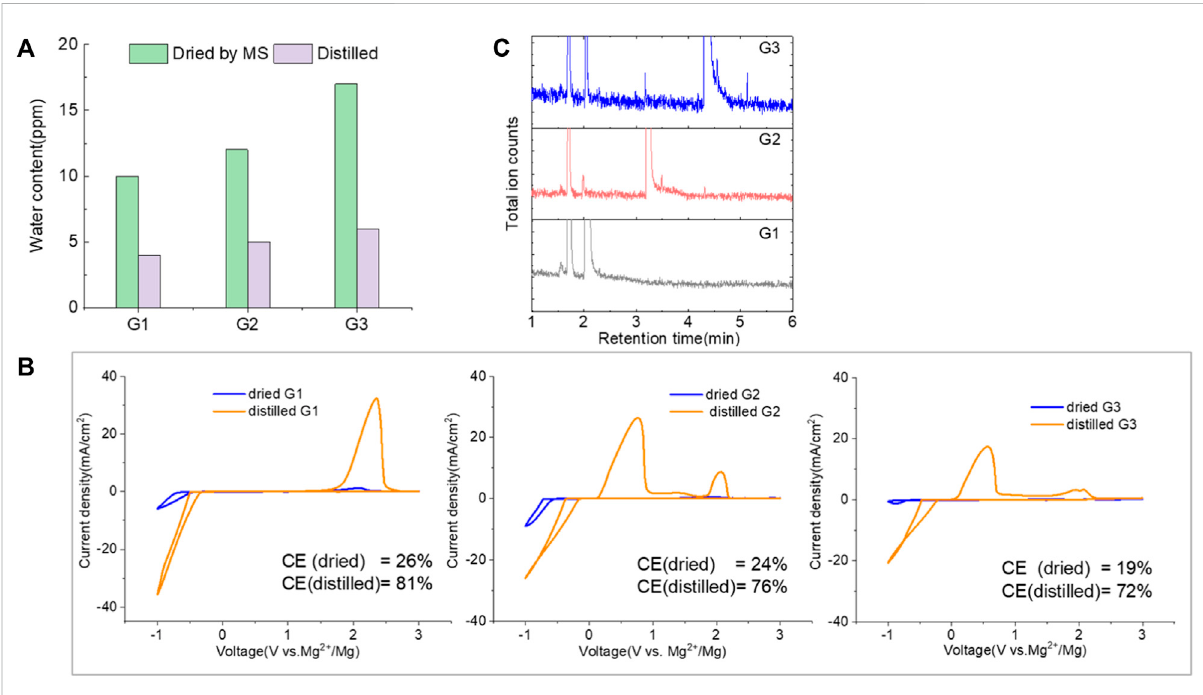
FIGURE 2 (A) Water content in the solvents dried by molecular sieve, distilled over Na/K measured via Karl Fischer titration. (B) Cyclic voltammograms (CVs) for the electrolytes with 0.5 M MgTFSI 2 in pretreated G1, G2, and G3 dried by molecular sieves and distillation methods. Pt was used as